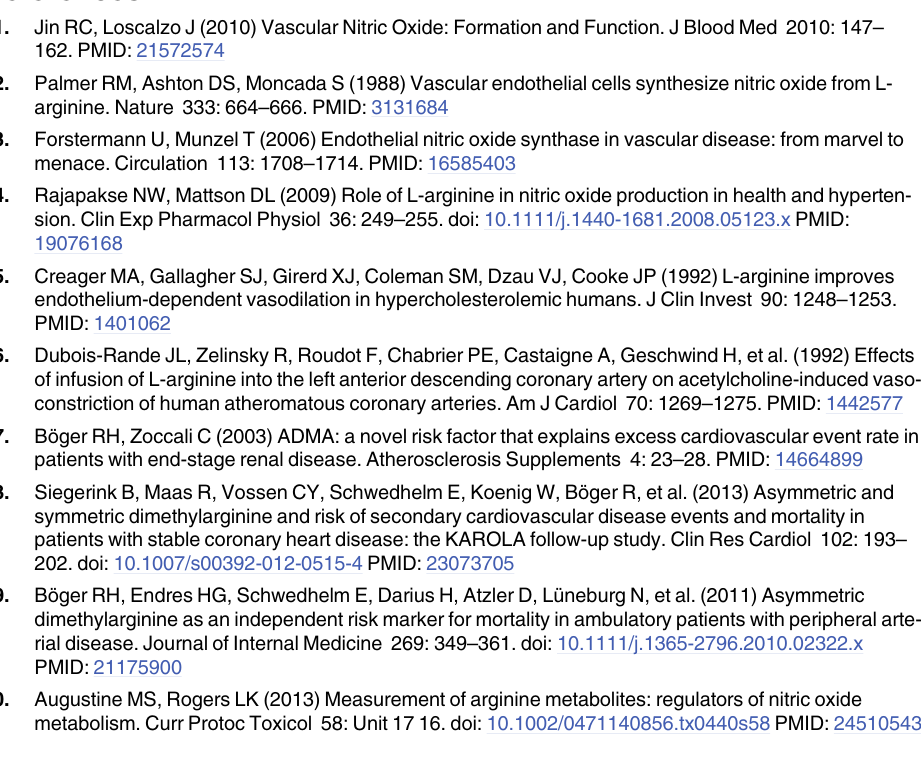
S2 Table. Association of arginine derivatives with the presence of atherosclerotic plaques. OR = odds ratio, CI = confidence interval, (cid:1) OR for a 1 unit increase in serum ARG derivative concentration or ARG/ADMA ratio. cIMT indicates carotid intima-media thickness; WHR, waist-to-hip ratio; eGFR, estimated-glomerular-filtration-rate; ADMA, asymmetric dimethy- larginine; SDMA, symmetric dimethylarginine; ARG, L -Arginine; DMA, dimethylarginine; ARG/ADMA, Arginine-asymmetrical dimethylarginine